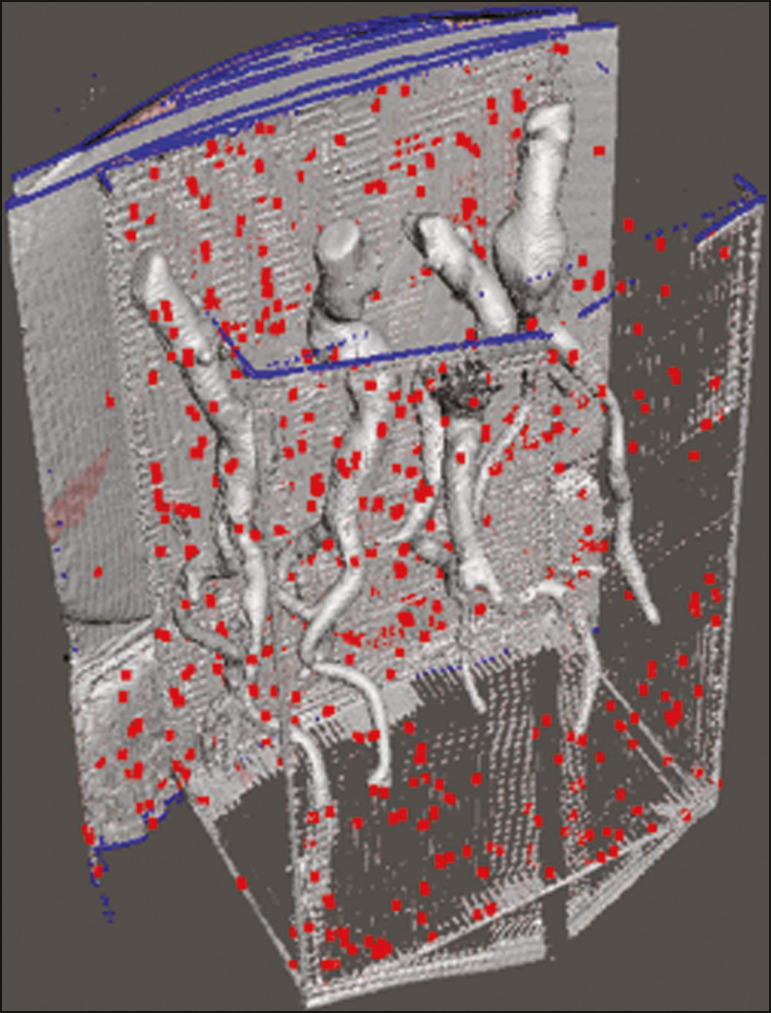
CT before deletion of the image of the cardboard box by the Meshmixer software.